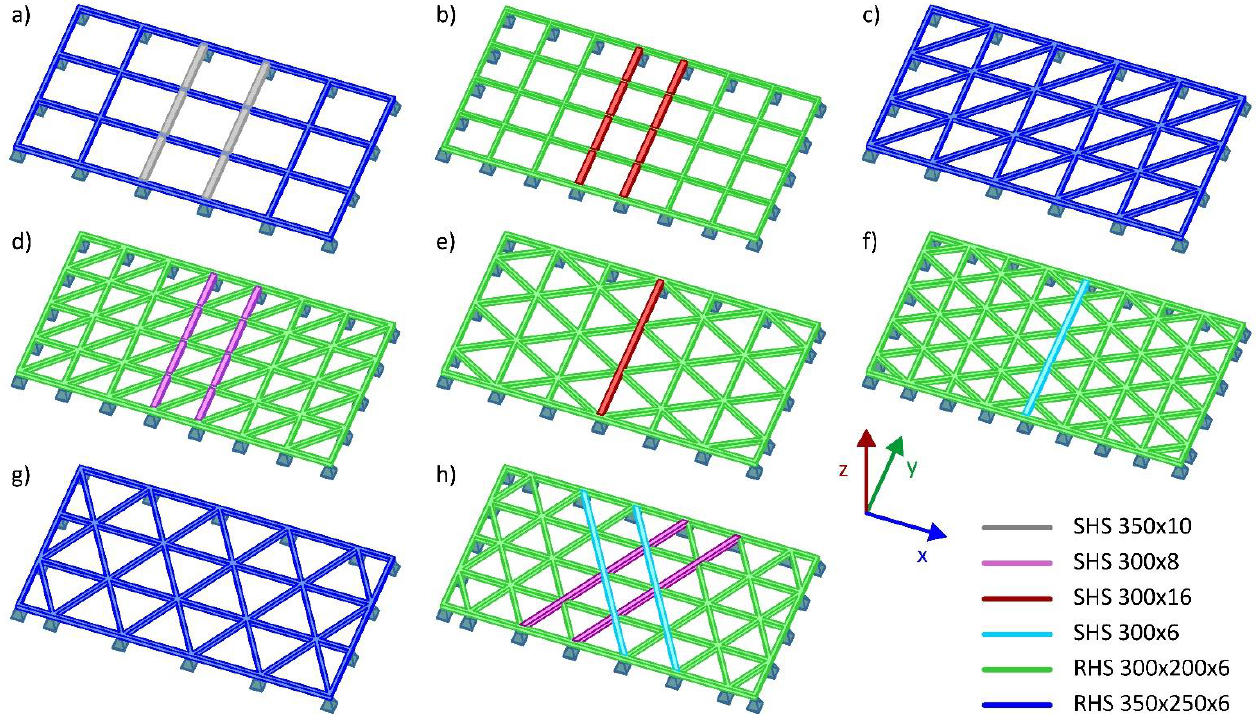
Figure 16. Grillage structures under consideration: ( a ) model OB, ( b ) model OS, ( c ) model RB, ( d ) model RS, ( e ) model TB, ( f ) model TS, ( g ) model LB, ( h ) model LS.